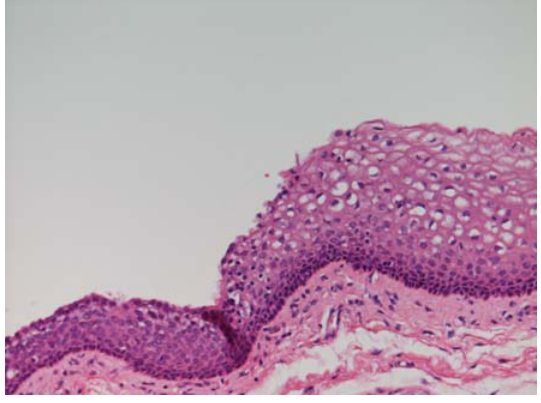
FIGURE 5 . Area of squamous metaplasia in the cyst lining. Magnification ×